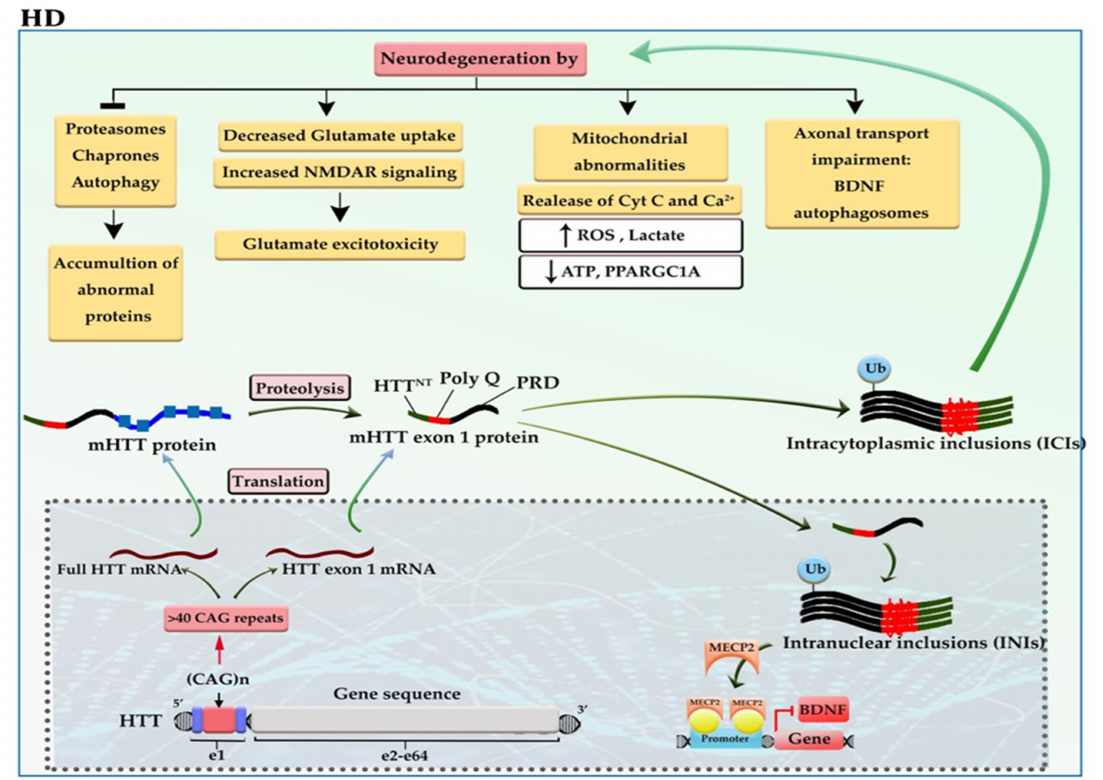
Figure 2. A schematic representation of the selected mechanisms in the pathogenesis of HD. HTT gene, located at 4p16, has 64 exons and a CAG trinucleotide repeat expansion in the exon 1 region. The CAG repeats in the coding sequence of mutant HTT (mHTT) produce mHTT exon 1 protein. mHTT exon 1 protein enters the nucleus. The gradual aggregation of mHTT exon 1 oligomers leads to the formation of large inclusions in the cytoplasm and nucleus of neural cells. The intracytoplasmic inclusions (ICIs) have various toxic effects on neural cells and can exacerbate the aggregation of mHTT exon 1 protein. Whereas the polyQ tract of intranuclear inclusions (INIs) recruits MECP2 to the promoter of BDNF , downregulating the expression of BDNF . BDNF : brain-derived neurotrophic factor; Cyt-c: cytochrome c; mHTT: mutant huntingtin; NMDAR: N-methyl-D-aspartate receptor; ROS: reactive oxygen